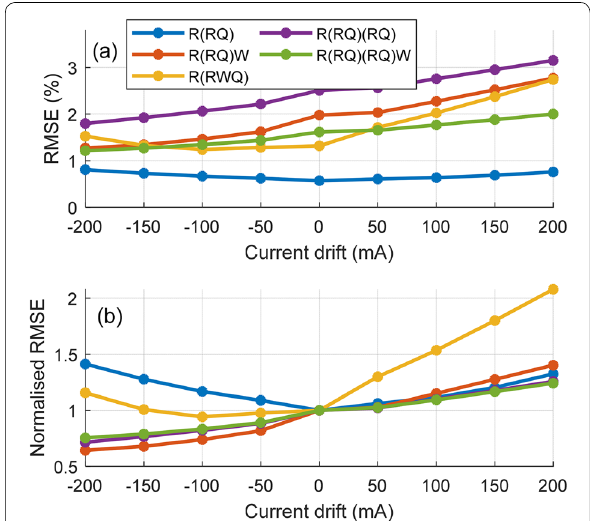
Figure 15 Influence of current drift on SOC estimation error: a RMSE versus current drift, b Normalised RMSE based on RMSE under no current